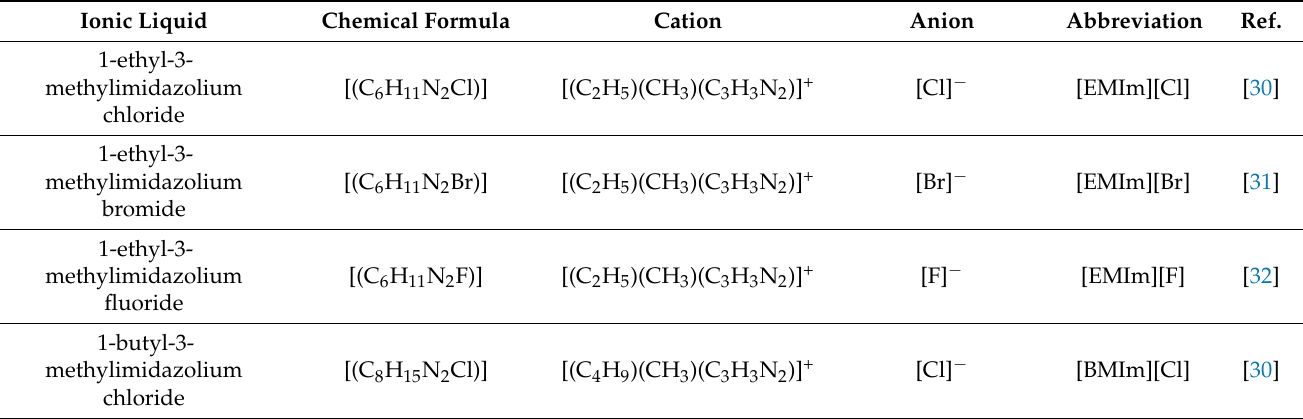
Table 2. Table showing the list of ionic liquids studied in this